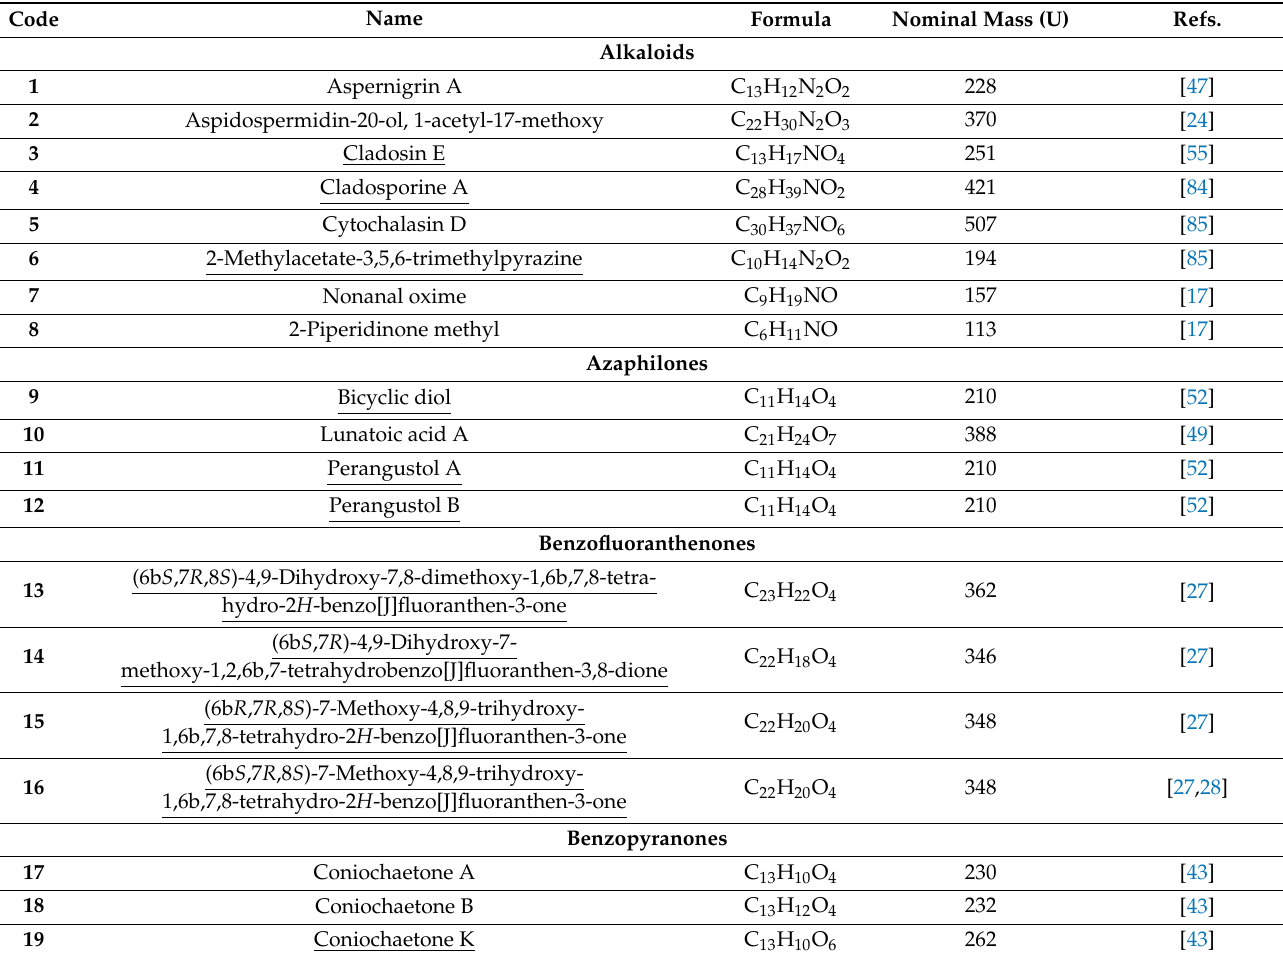
Table 2. List of secondary metabolites produced by Cladosporium species. The Latin suffix “ bis ” is added when the same name has been previously introduced for another compound. The names of novel compounds are underlined. Code Name Formula Nominal Mass (U)